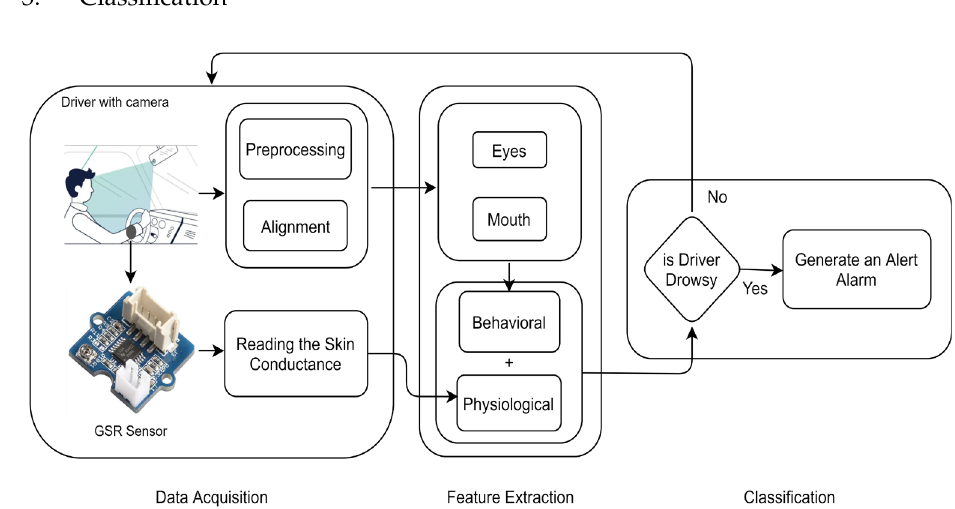
Figure 10. The architecture of the proposed hybrid model .